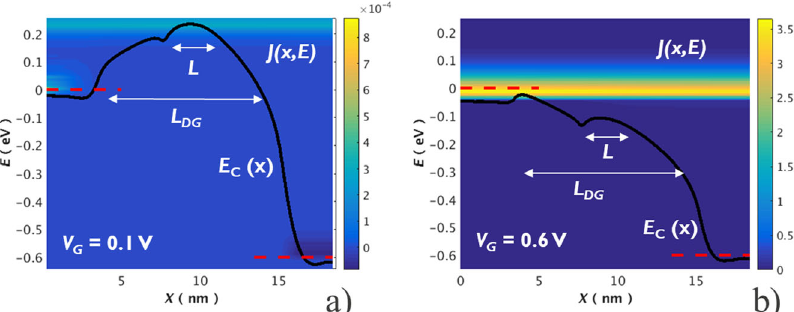
Fig. 13 Current spectrum and top conduction-band edge along the channel direction of a L = 3 nm HfS 2 D 2 -FET. J(E, x) (surface plot) and E C ( x ) ( − ) of the simulated intrinsic ( N SD ≤ 1 × 10 19 cm − 3 ) L = 3 nm HfS 2 nD 2 -FET of Fig. 11a (with the design of Fig. 12c) a in off-state at V G = 0.1 V, and b in on-state at